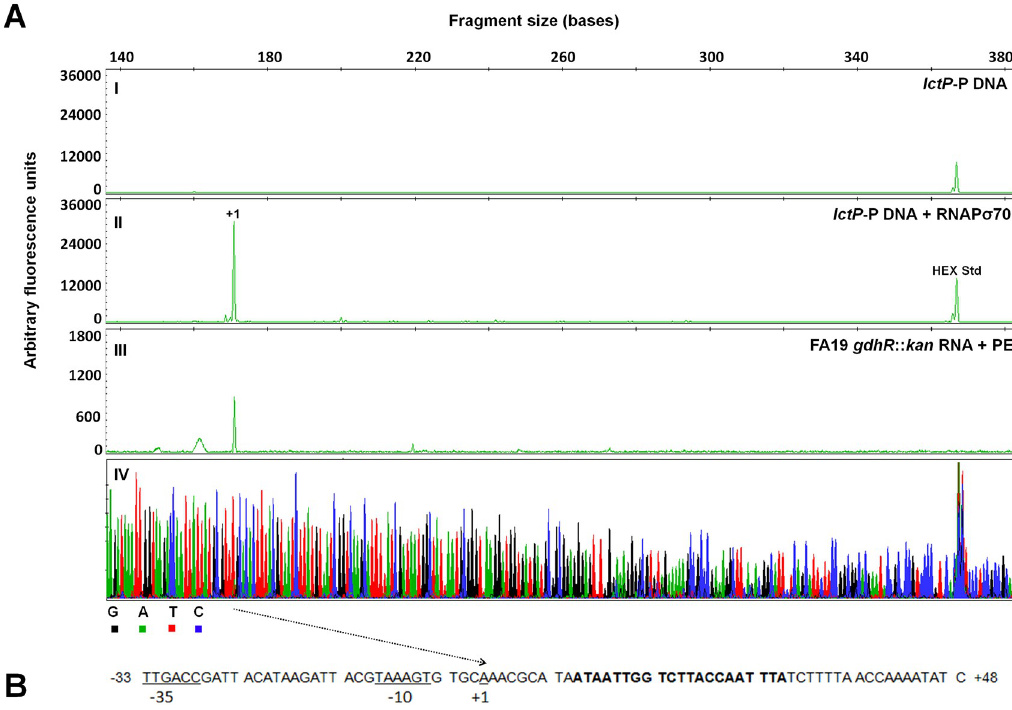
Fig 4. Mapping of the lctP transcriptional start site by in vitro transcription and primer extension (PE). A. A lctP DNA fragment spanning nucleotides -192 to +381 relative to the TSS was incubated with (II) or without (I) purified RNAP σ 70. The resulting RNA transcript (+1) and total RNA from gdhR :: kan mutant cells (III) were purified and annealed with primer HEX- lctP-IvT complimentary to the lctP coding sequence and extended as described in Methods . The resulting fluorescent peaks were analyzed in a capillary electrophoresis sequencer. A HEX-labeled 369 bp DNA standard (HEX Std) was added to in vitro transcription reactions before analysis. Manually-generated sequencing reactions (IV) were obtained with primer HEX-lctP-IvT and the above lctP DNA template. GeneMapper was used to align the resulting electropherograms, to estimate the height (y axis) and the size (x axis at the top) of the peaks and to obtain a color-coded overlay representation of the template strand sequence (IV). B. Architecture of the lctP promoter showing the mapped TSS (+1) and sigma-70 promoter elements underlined. An inverted repeat matching the consensus FadR DNA-binding motif is represented in bold font.